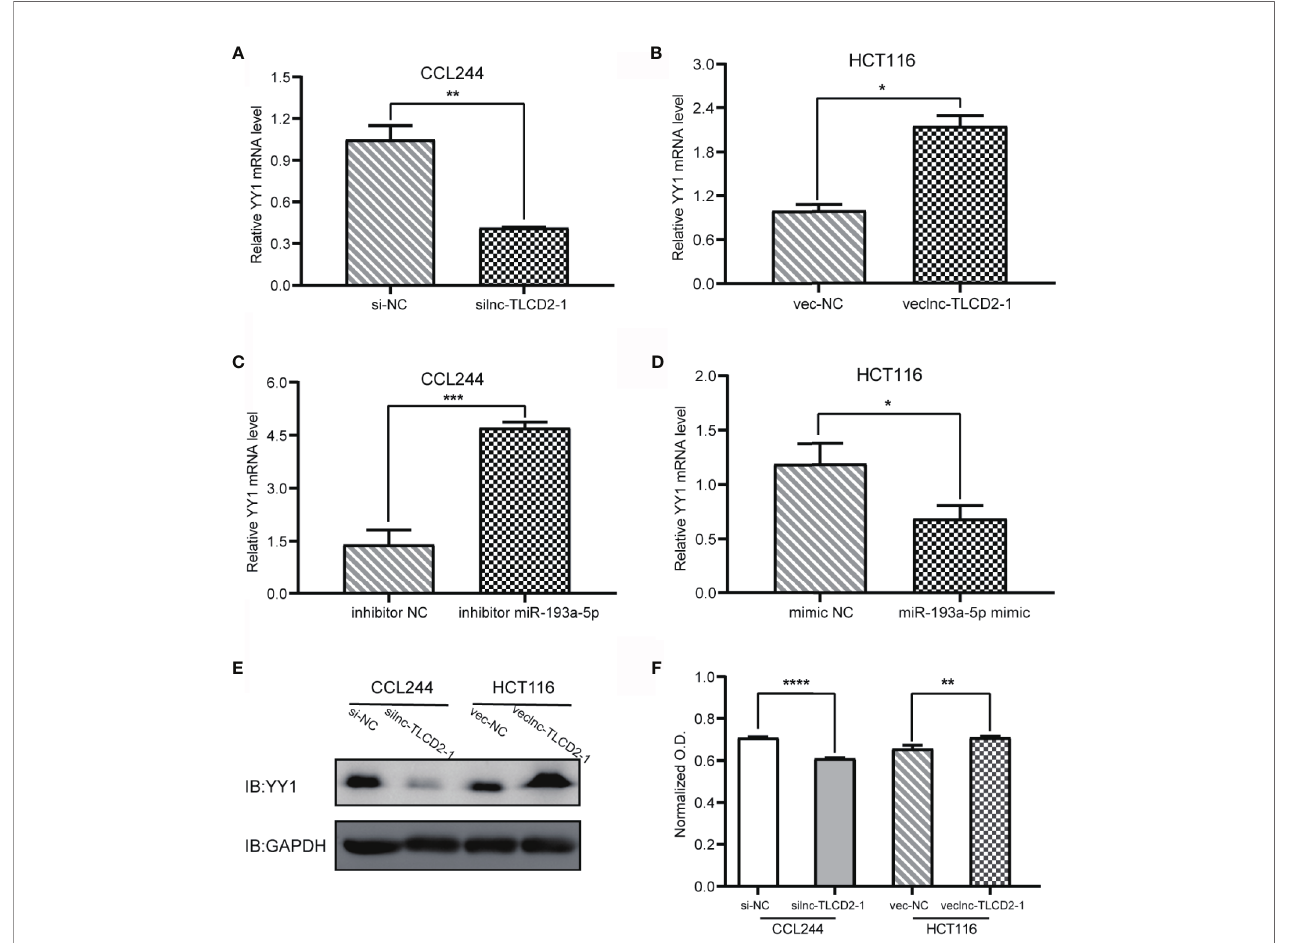
FIGURE 5 | Regulation of lnc-TLCD2-1 and hsa-miR-193a-5p on YY1, and the effect of lnc-TLCD2-1 on CRC proliferation. (A) In CCL244, the expression of YY1 decreased after interference of lnc-TLCD2-1. (B) The expression of YY1 increased after overexpression of lnc-TLCD2-1 in HCT116. (C) YY1 was increased after inhibition of miR-193a-5p in CCL244. (D) YY1 was down-regulated after upregulation of miR-193a-5p in HCT116. (E) Western Blot detected the change of YY1 in protein level. (F) CRC proliferation was inhibited or promoted by interfering or upregulating the expression of lnc-TLCD2-1 in CCL244 and HCT116, respectively. (P<=0.05 means statistically signi fi cant, *p < 0.05, **p < 0.01, ***p < 0.001, ****p <